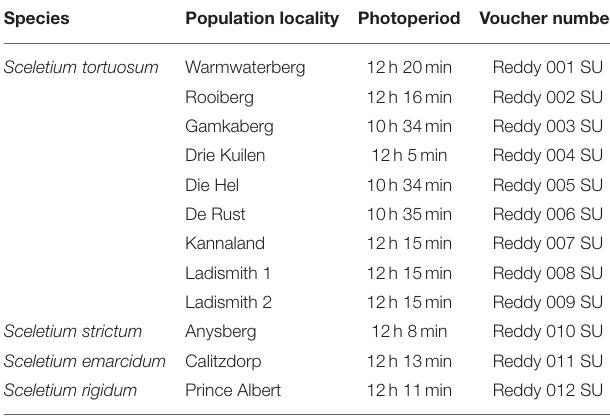
TABLE 1 | Species, population localities, and photoperiods of samples investigated in this study.